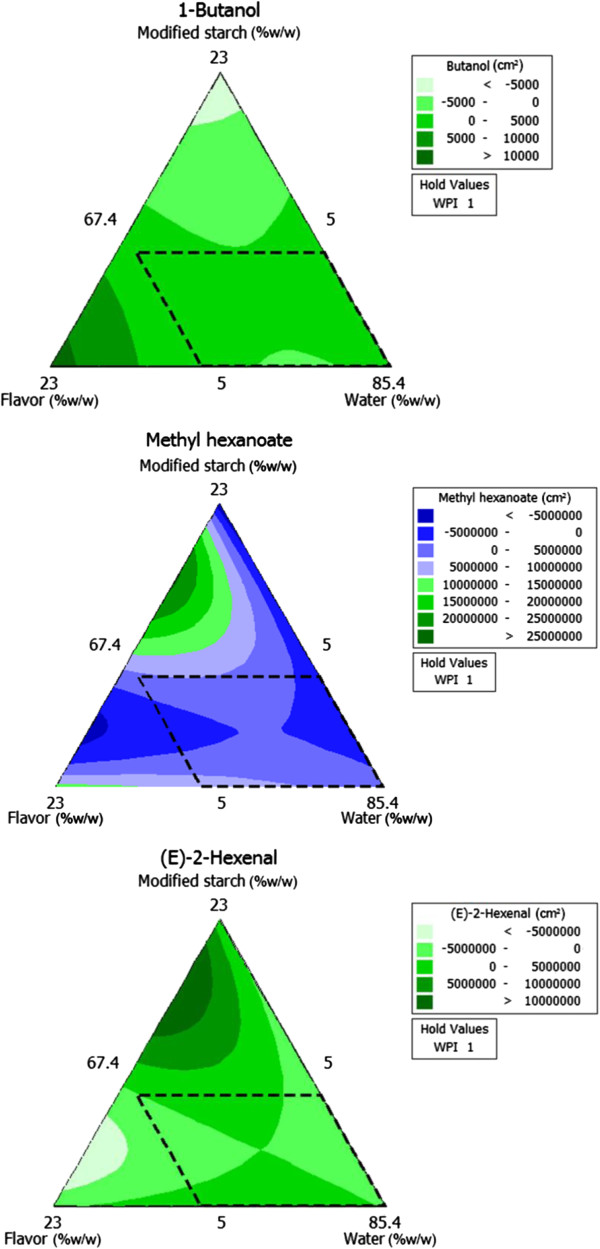
Mixture contour plots of three soursop flavor compounds. Diamond-shaped subregion is the constrained experimental region.